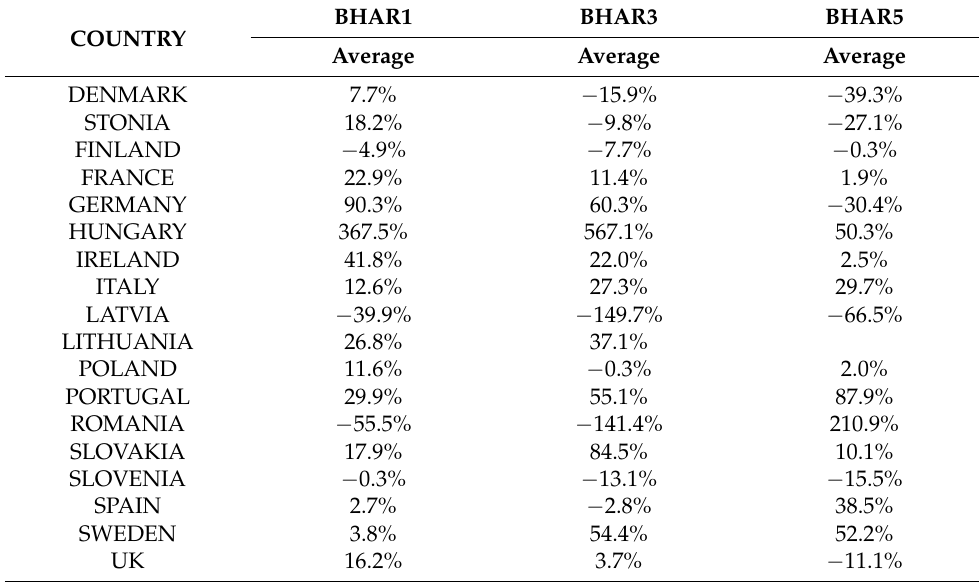
Table 2. Performance of IPOs by